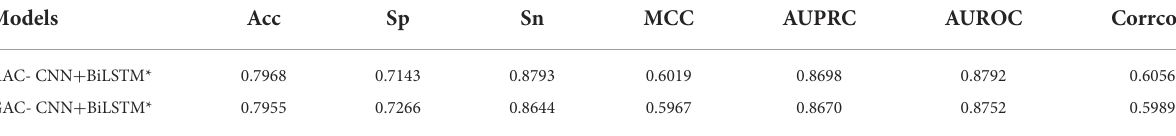
TABLE 4 Performance of CNN + BiLSTM model on AAC_test under multi-task learning. Models